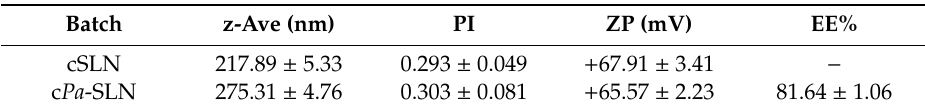
Table 1. Mean particle size (z-AVE), polydispersity index (PI), zeta potential (ZP) and encapsulation